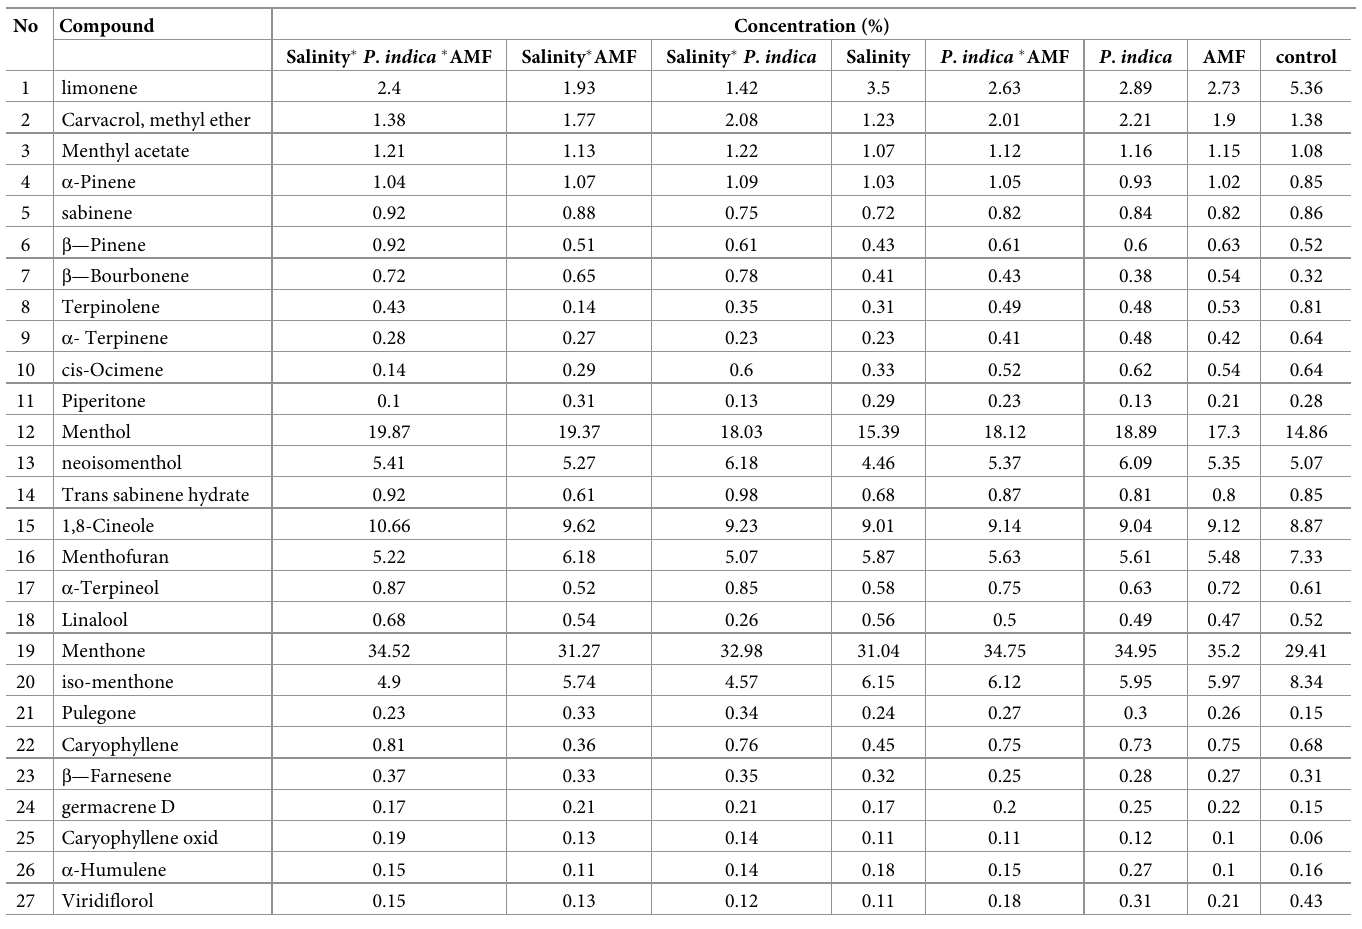
Table 4. Effect of microbial inoculation on Mentha piperita essential oils composition under salinity